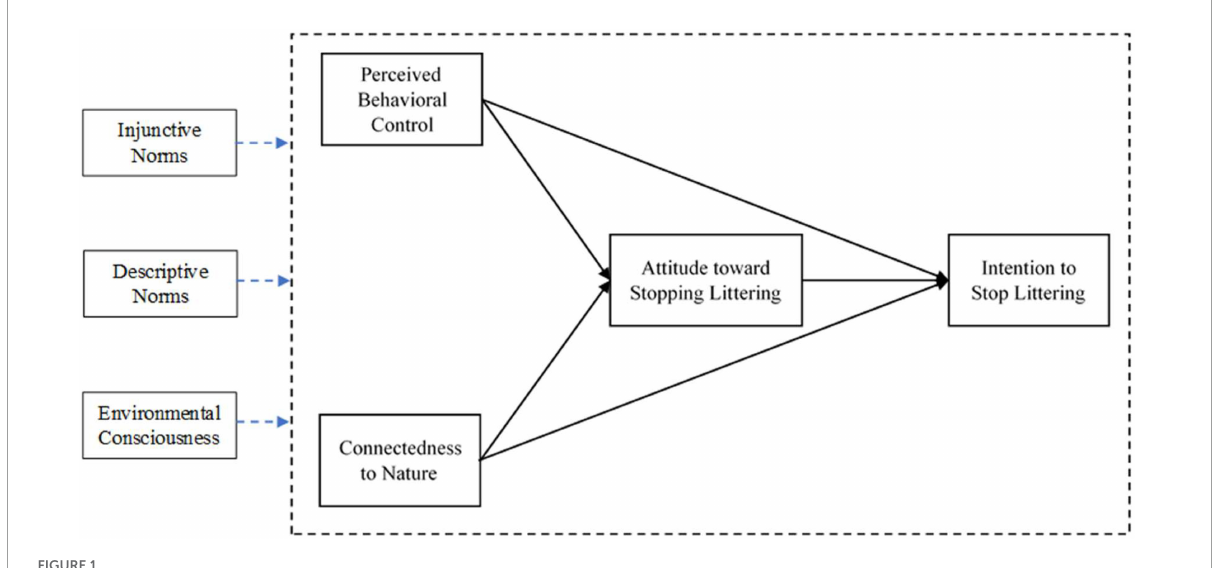
FIGURE1 Conceptual model for explaining littering